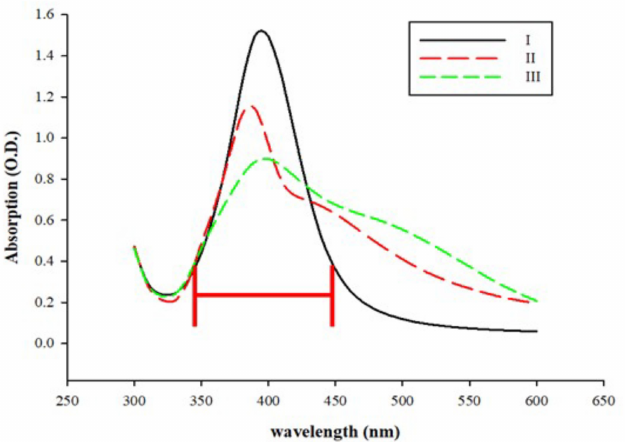
Figure 2. Effects of reagent addition sequence on the formation of AgNPs: UV–Vis spectrum ( λ = 300–600 nm) of silver nanoparticles. Effect of reagent addition order on silver nanoparticles synthesized by silver nitrate (AgNO 3 ), trisodium citrate (SC), and sodium borohydride (NaBH 4 ). I: AgNO 3 + SC mix 5 min, add NaBH 4 then mix for 2 h. II: AgNO 3 + NaBH 4 mix 5 min, add SC,